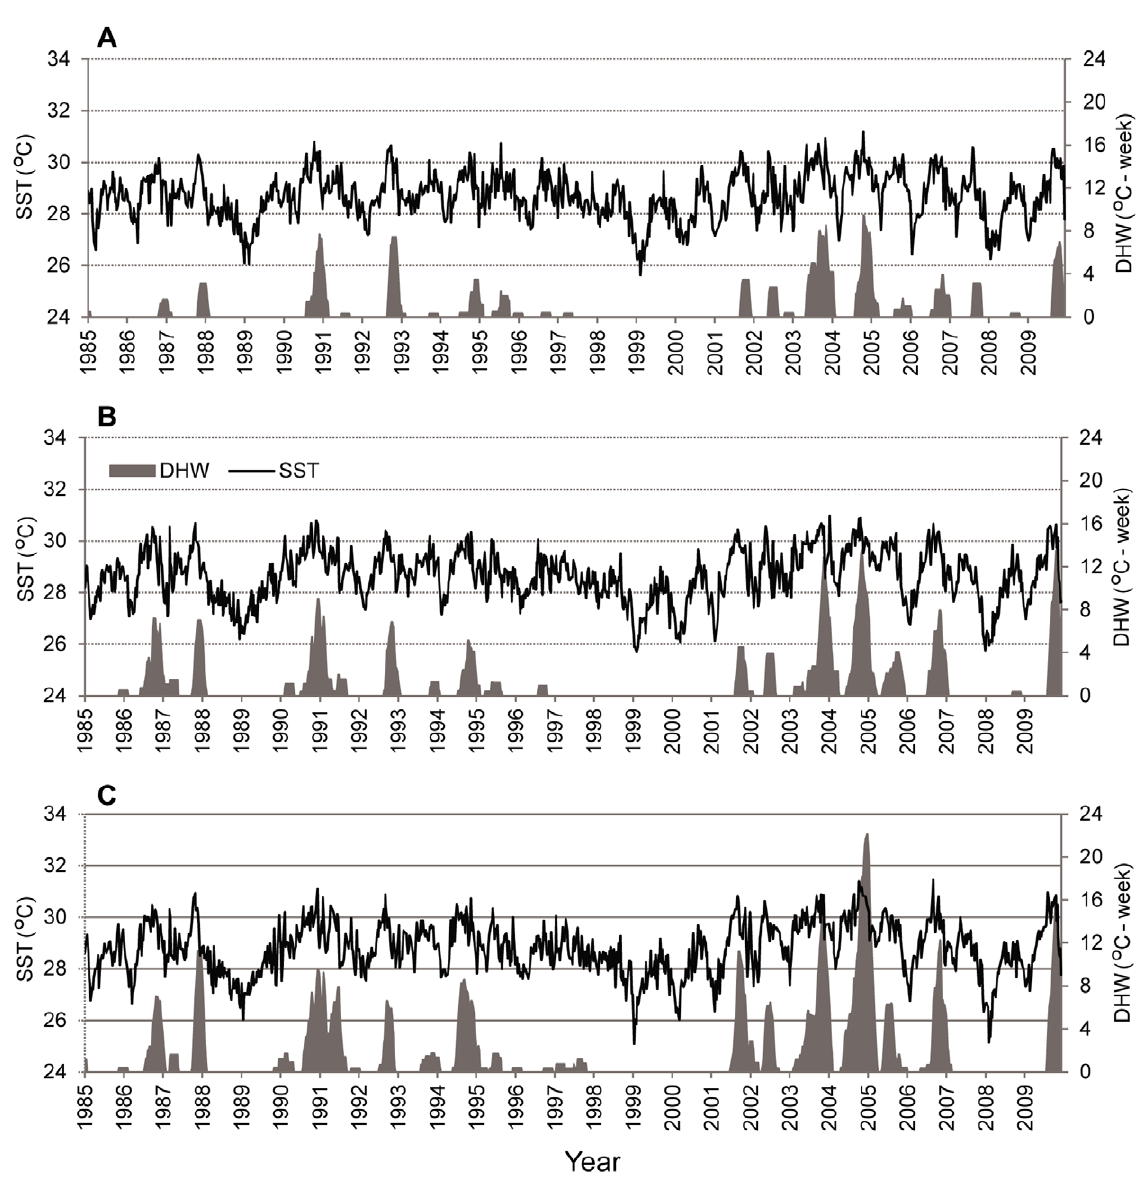
Figure 3. Weekly sea surface temperature ( 6 C; black) and degree heating weeks ( 6 C ? week; gray) from 1985 through 2009. Plots show the average of the values from the 4 km 2 AVHRR grid cells that include field sites in (A) Butaritari, (B) Abaiang and North Tarawa, and (C) South Tarawa.